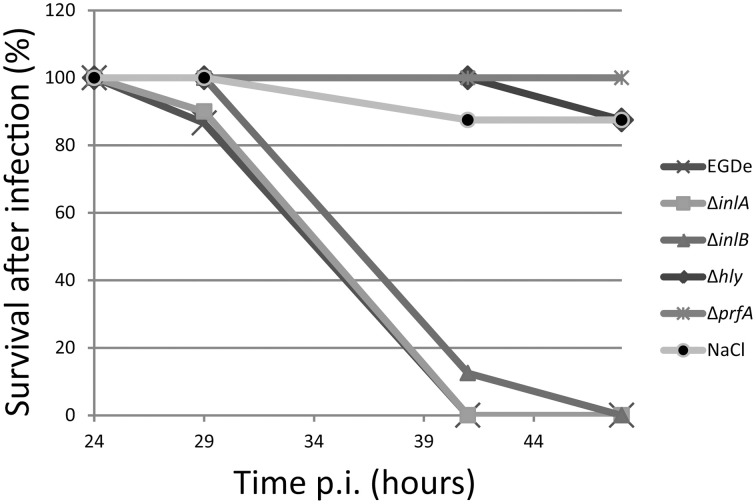
Survival curve of chicken embryos infected with L. monocytogenes wild-type ΔprfA, Δhly, ΔinlA or ΔinlB mutant strains. ~5 × 102 bacteria were injected into 9-day old chicken embryos and death was monitored from 24 to 48 h post-infection. Death is shown as mean of 2 experiments (n = 15, 9, 12, 11, 12, and 14 for WT, ΔprfA, Δhly, ΔinlA, ΔinlB, and NaCl respectively).